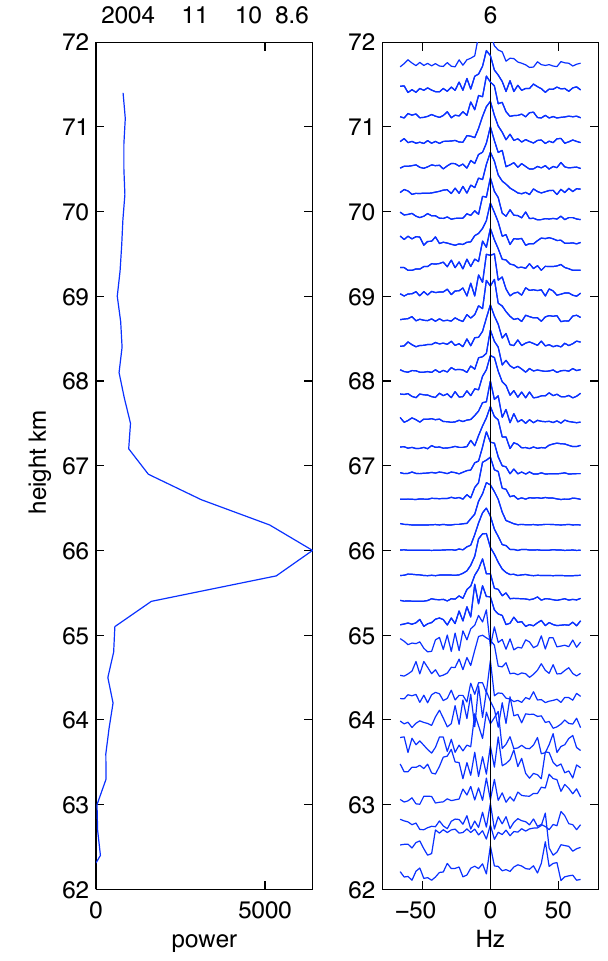
Fig. 3. EISCAT observations averaged 08:36–08:42 UT on 10 November 2004. Left-hand panel shows the height profile of echo power, right-hand panel shows echo spectra, normalised by the echo